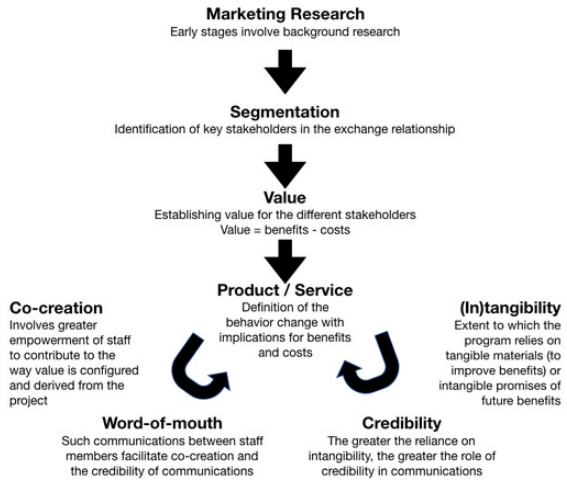
Figure 1. Social marketing concepts involved in the implementation of the behavior change intervention.